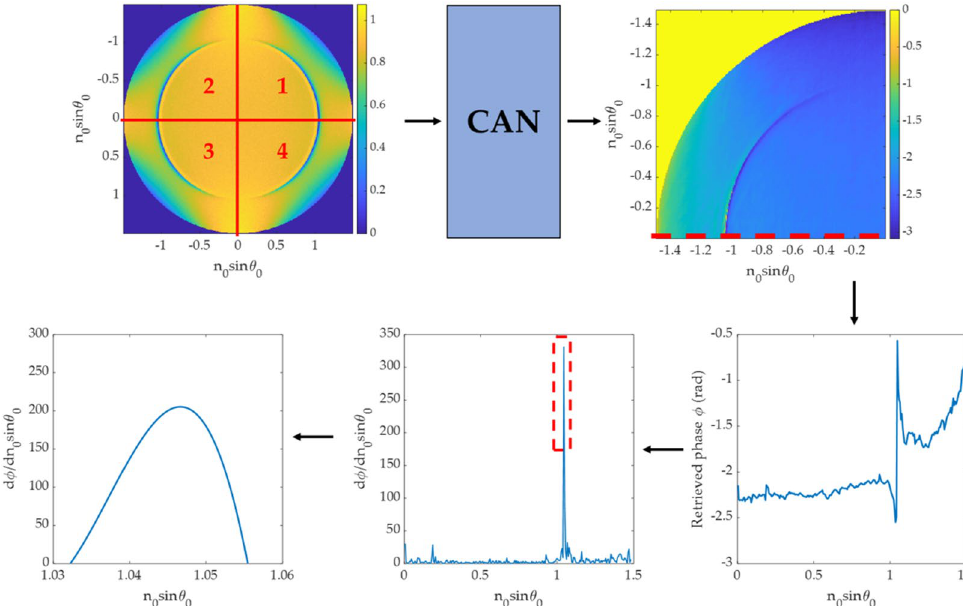
Figure 6. Steps in determining plasmonic angle for the DL-based method.